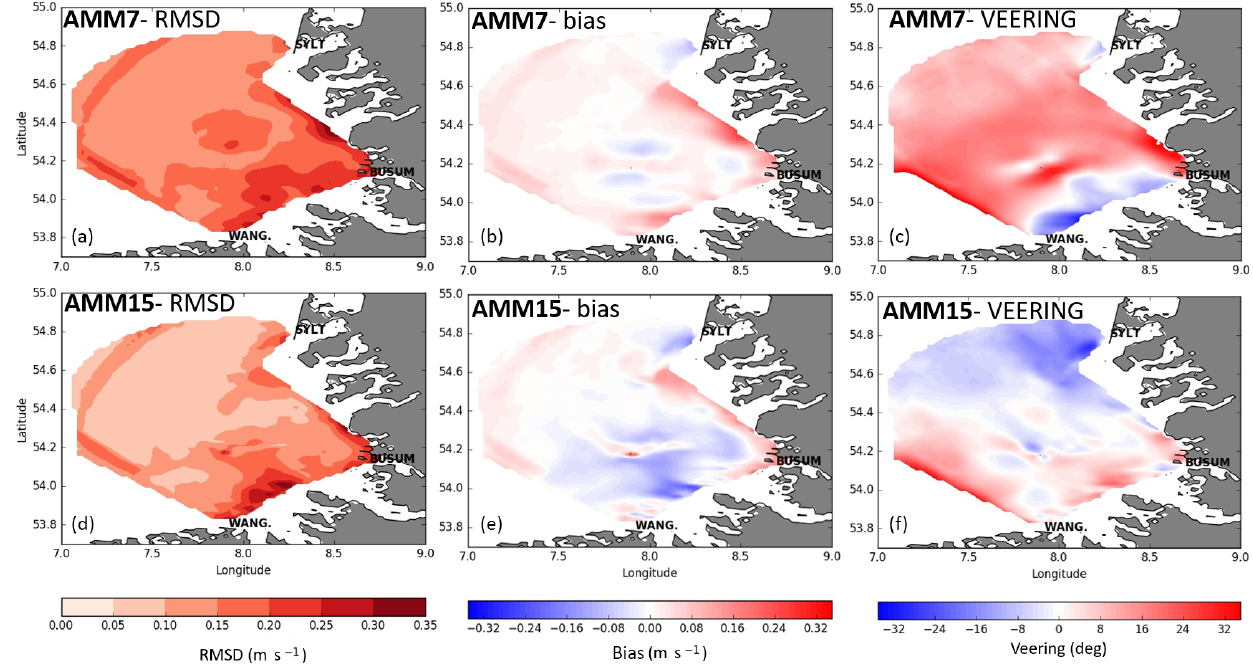
Figure 7. Plots of statistics between HF radar surface current observations and AMM7 (a–c) and AMM15 (d–f) for the high-pass-filtered data (tidal signal). Bias (observation–model) and RMSD (in ms − 1 ) are estimated on the velocity vector magnitudes. (c, f) Phase or veering. Positive (negative) veering represents a clockwise (anti-clockwise) angle of AMM7 (a–c) or AMM15 (d–f) vectors with respect to the HF radar vectors. SYLT, WANG, and BUSUM show the locations of the three HF radars on the islands of Sylt and Wangerooge, and in Büsum,